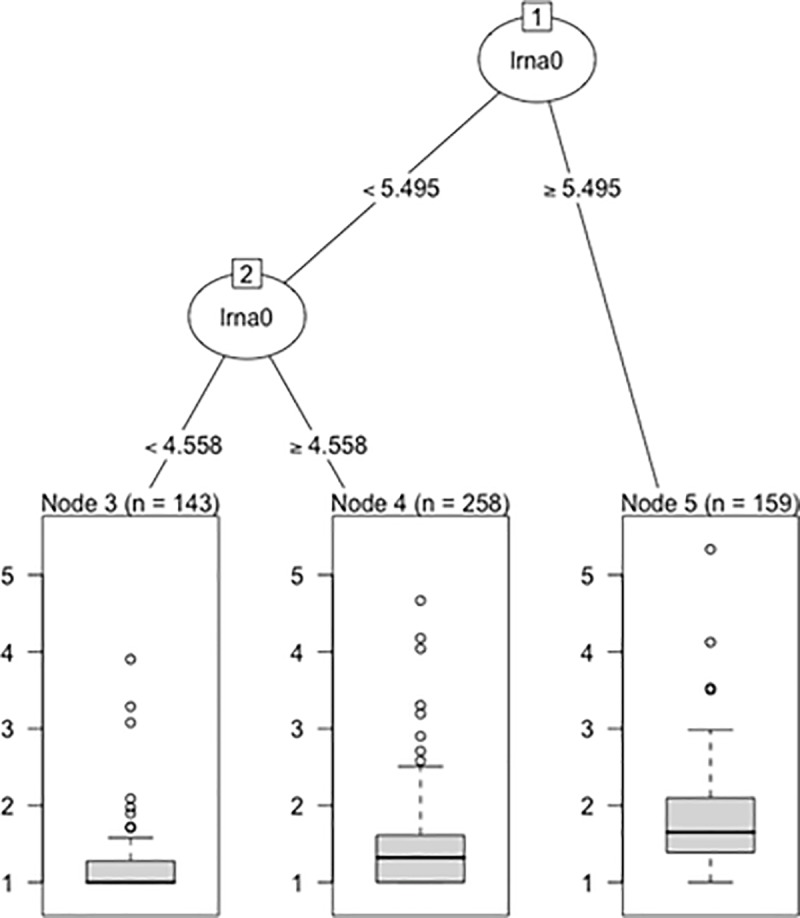
Regression tree by recursive partitioning: Description of lrna0 as predictor of lrna6.The first split was under the rule of lrna0 < or ≥ 5.495 (312,698 copies/mL), and the second was under the rule of lrna0 < or ≥ 4.558 (36,141 copies/mL). Three terminal nodes were produced. The distributions of lrna6 after partitioning are visually summarized. n: number of patients; lrna0: log10-transformed plasma HIV RNA at T0; lrna6: log10-transformed plasma HIV RNA after 6 months of cART.